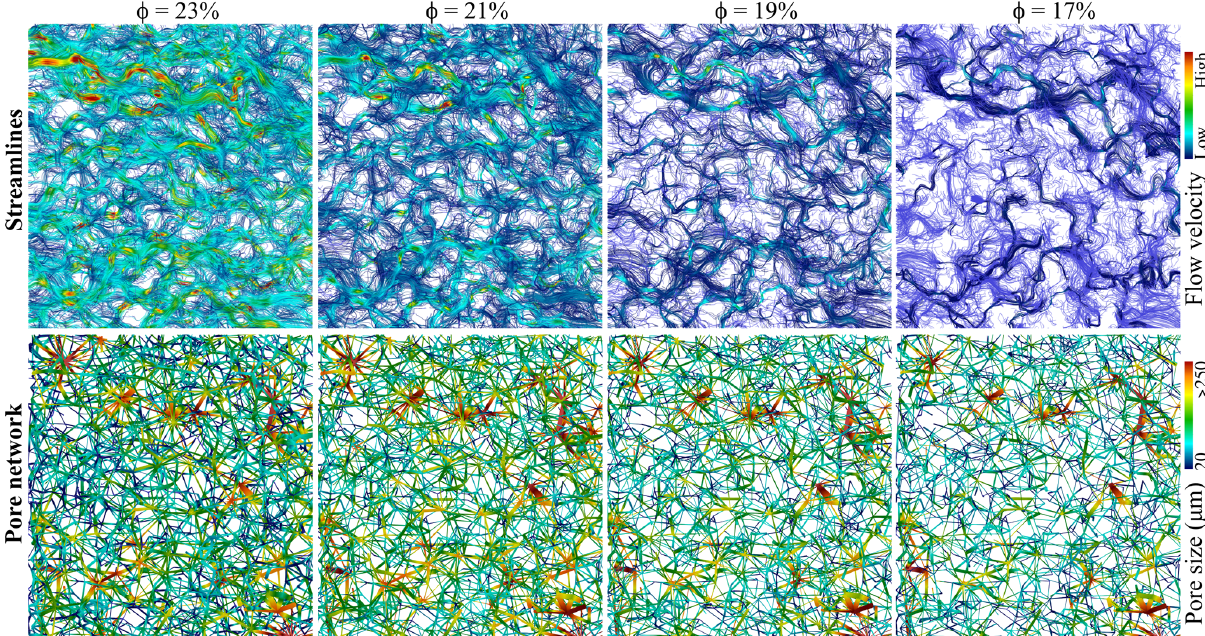
Figure 4. Evolution of the streamlines for flow in x direction (red: high velocities, blue: low velocities) and the pore network (red: high pore diameter, blue: low pore diameter) considering a transport-controlled reaction regime with preferential precipitation in regions of high flow velocities ( > 75th